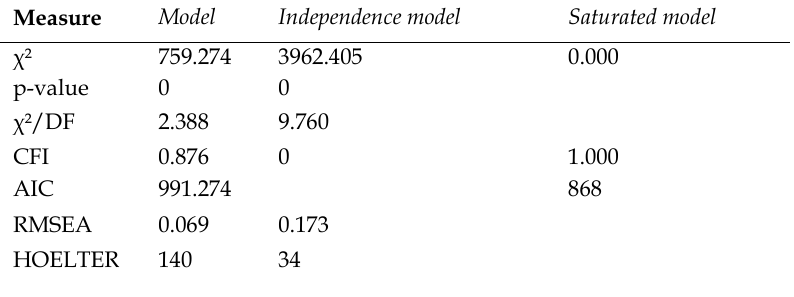
Table 5. Goodness-of-Fit SEM full model stage-of-change